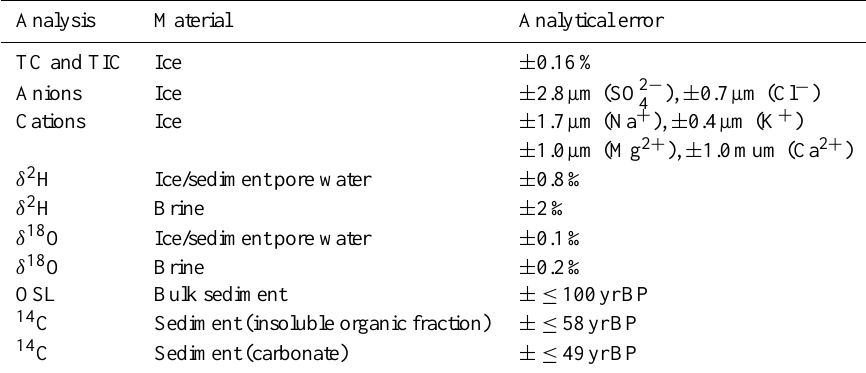
Table 1. Summary of analyses and analytical